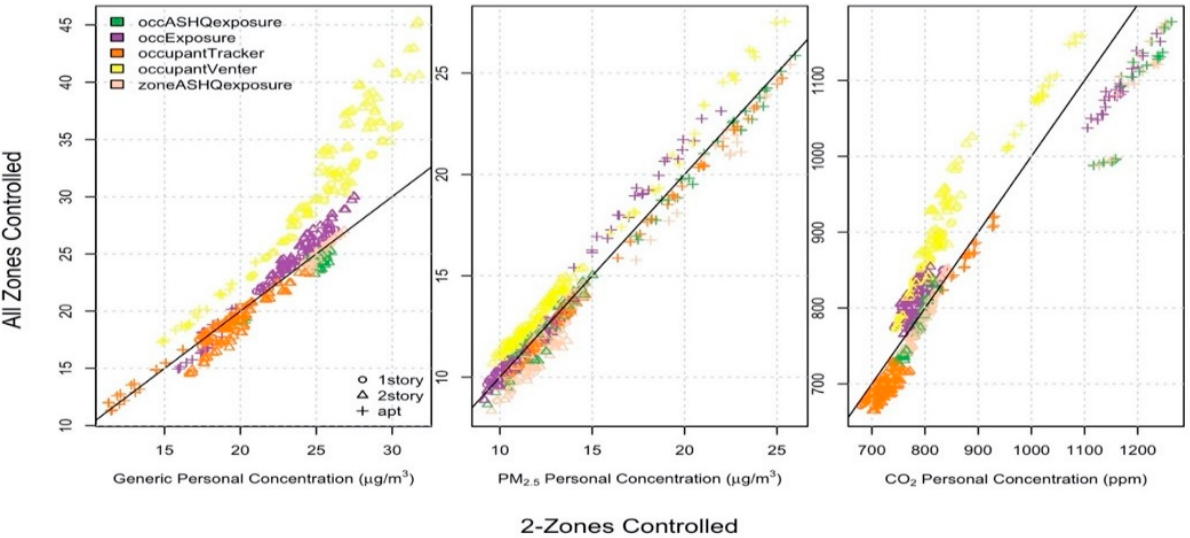
Figure 5. Comparison of annual median personal contaminant exposure by for systems controlling all zones or only two zones for different control strategies (colours) and dwelling types (symbols).